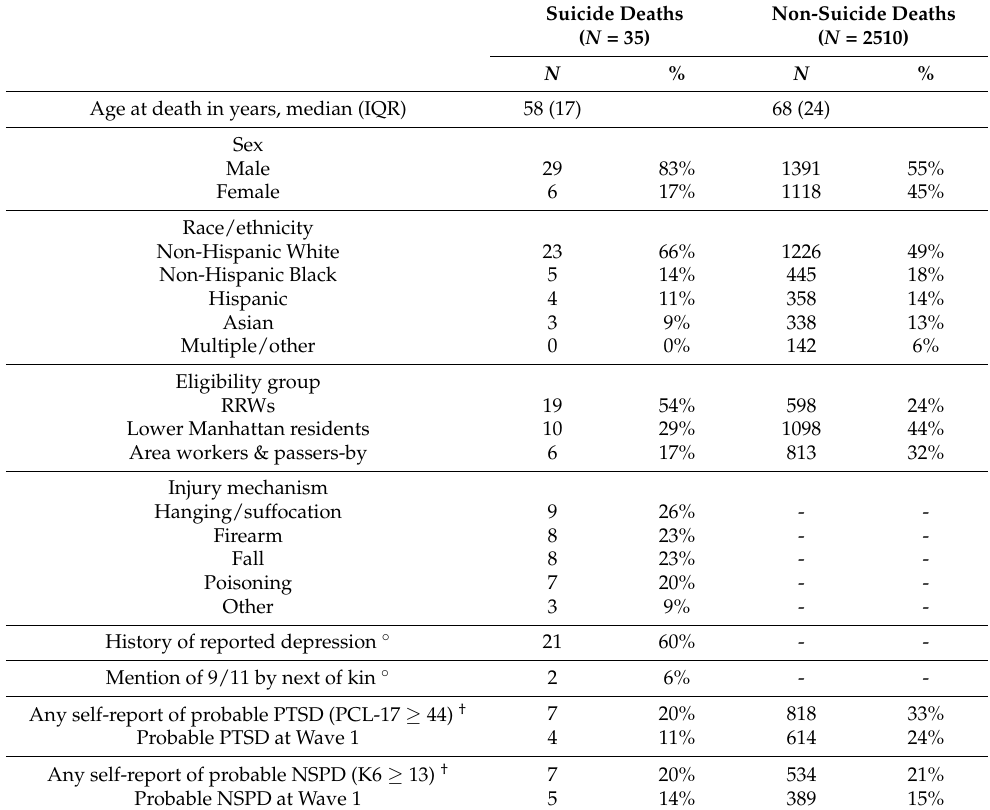
Table 1. Demographic characteristics and potential 9/11-related mental health conditions among WTCHR enrollees who died by suicide vs. non-suicide in NYC during 2004–2018.